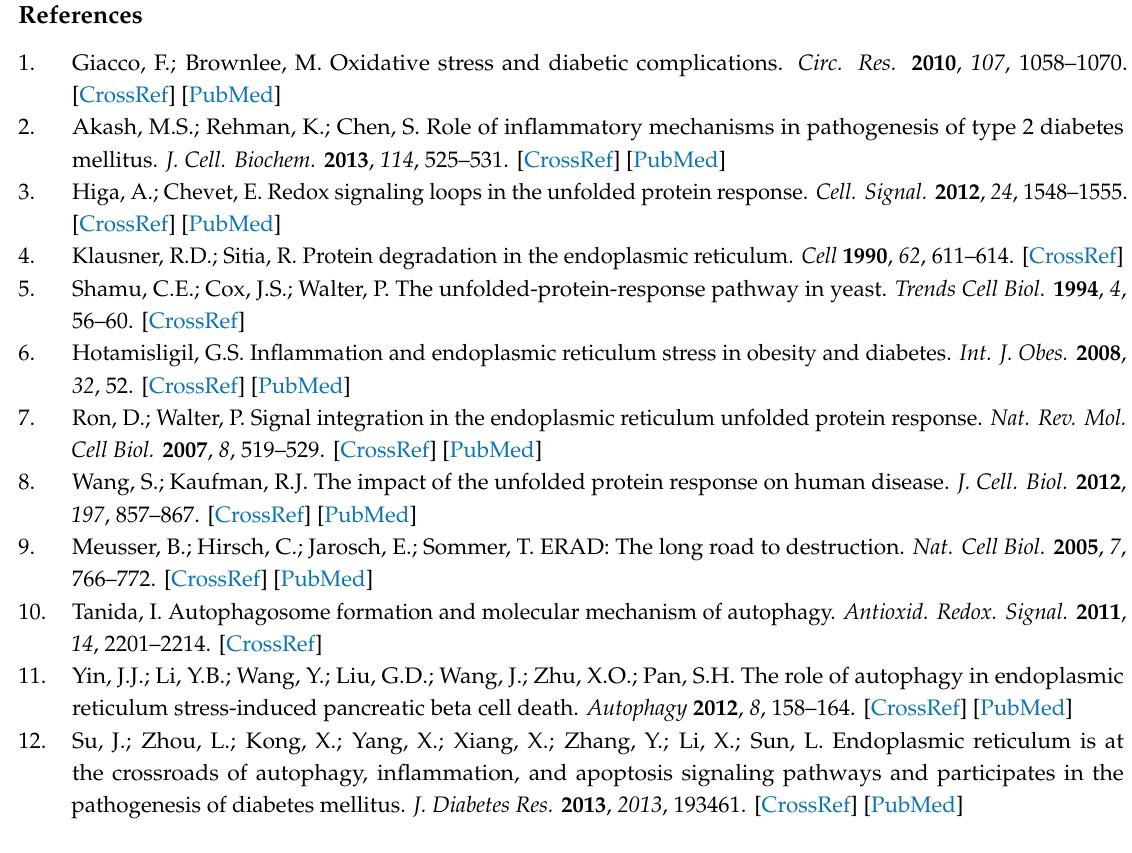
Figure S1: Leukocyte-enfothelium interaction evaluation under SS-31 and SS-20